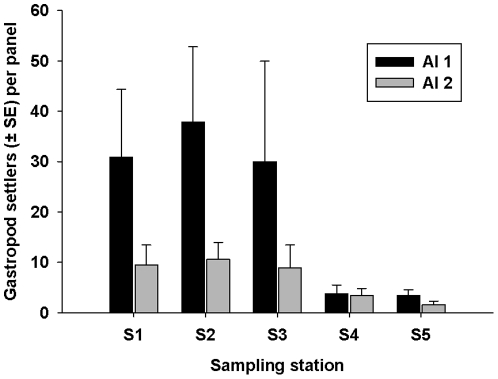
Mean number of gastropod settlers (± SE) per settlement panel (n = 8) found on artificial islands (n = 2) at different distances from Kapiti Island (S1–S5).S1 = 1 km S, S2 = 0.5 km N, S3 = 5 km N, S4 = 15 km N, S5 = 50 km N.